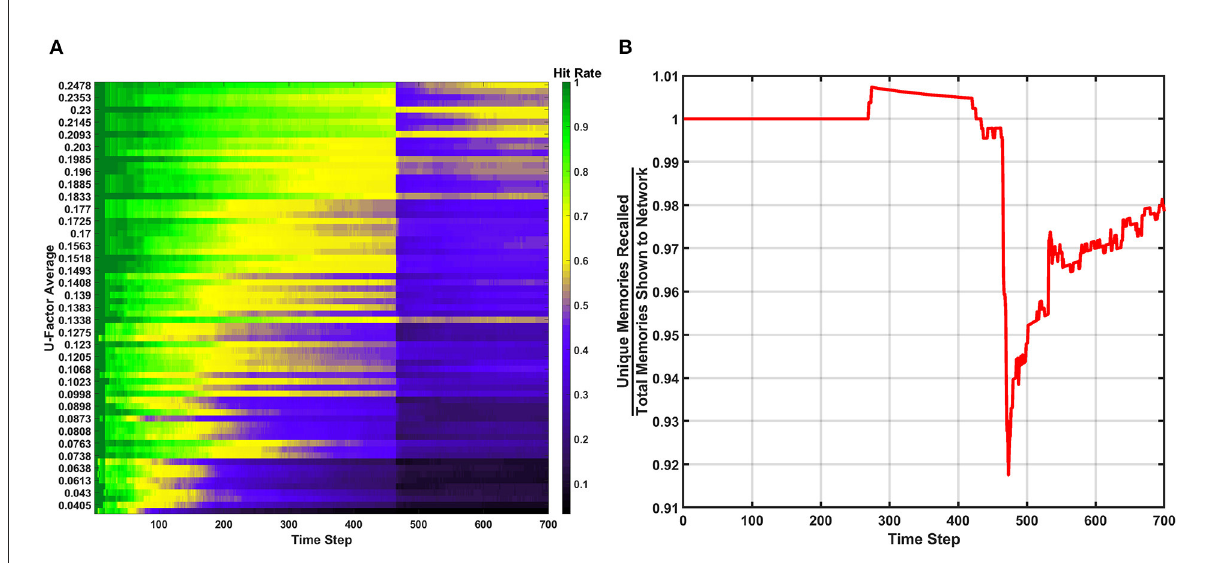
FIGURE8 Results of the erase behavior when R th = 400 v ON . (A) The hit rate plot shows a clear drop when the erasure event occurred between the 400th and 500th time step. A period of post-erase recovery then ensues. (B) The unique memory ratio tells a similar story to the hit rate, where the erasure event incurs a short-term performance hit, but shows a post-erase recovery phase where the network recovers to a point slightly higher than the end result from the basic